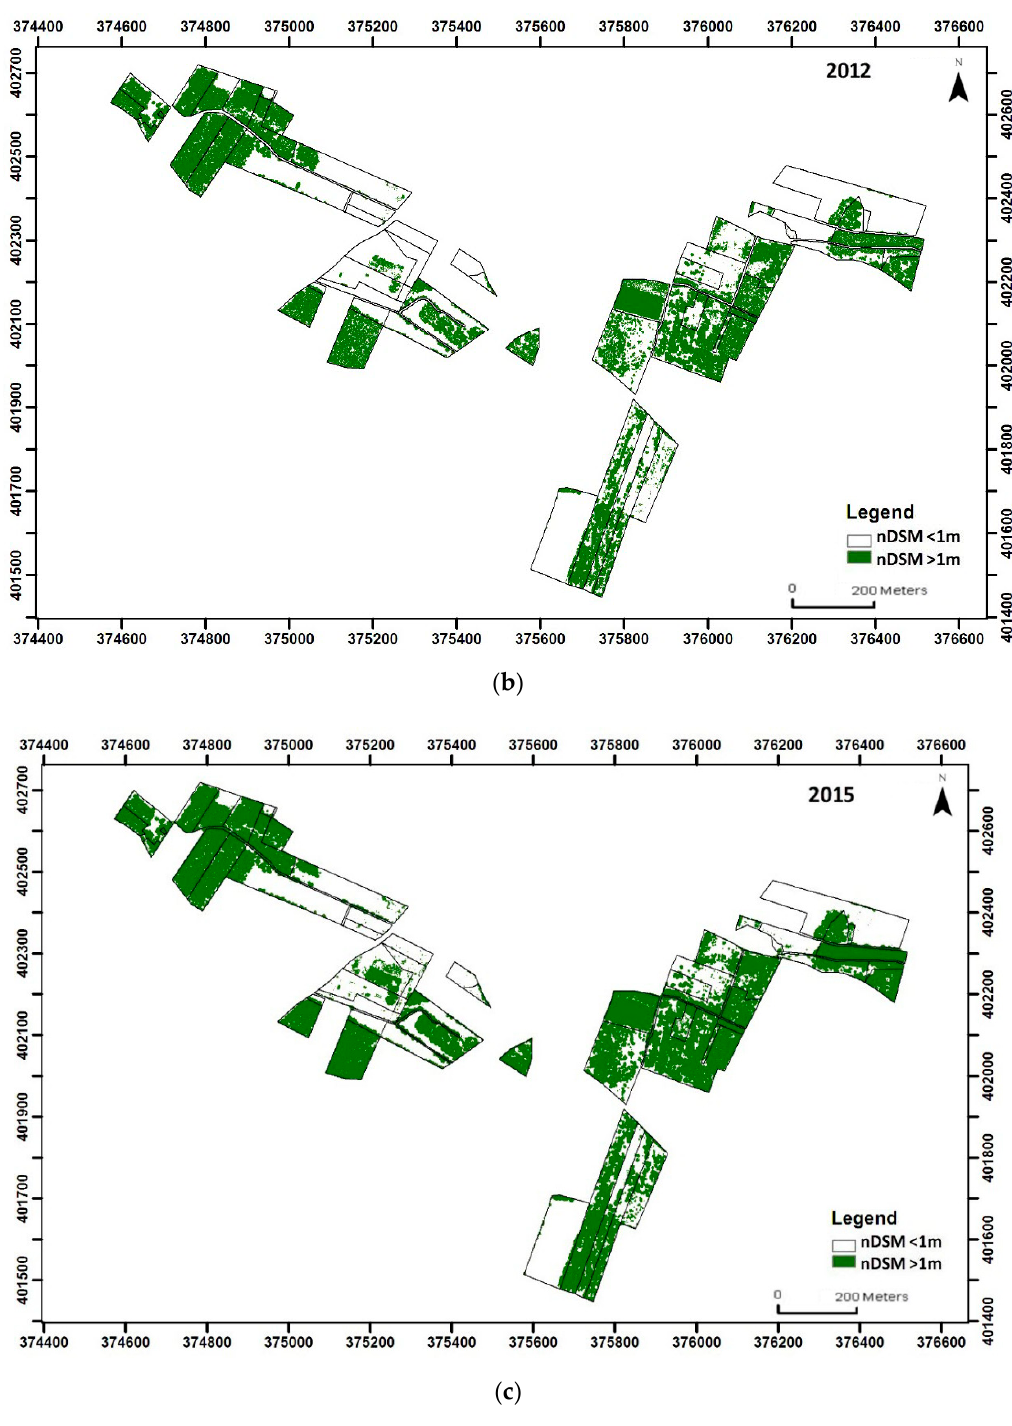
Figure 5. The graphic results of ALS point cloud processing—reclassification (nDSM > 1.0 m): ( a ) 2007; ( b ) 2012; ( c ) 2015.